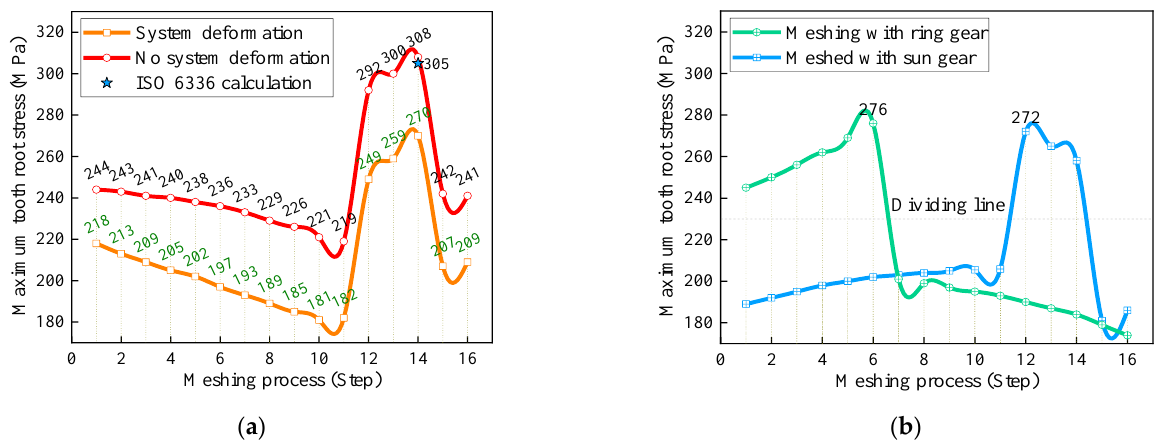
Figure 13. Maximum tooth root stress history: ( a ) sun gear; ( b ) planet gear.